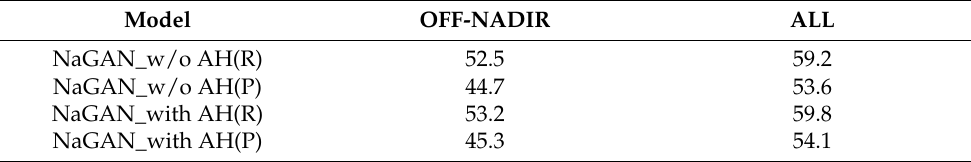
Table 5. Performance comparison on adversarial head. (R): AR@0.5, (P): AP@0.5 (in